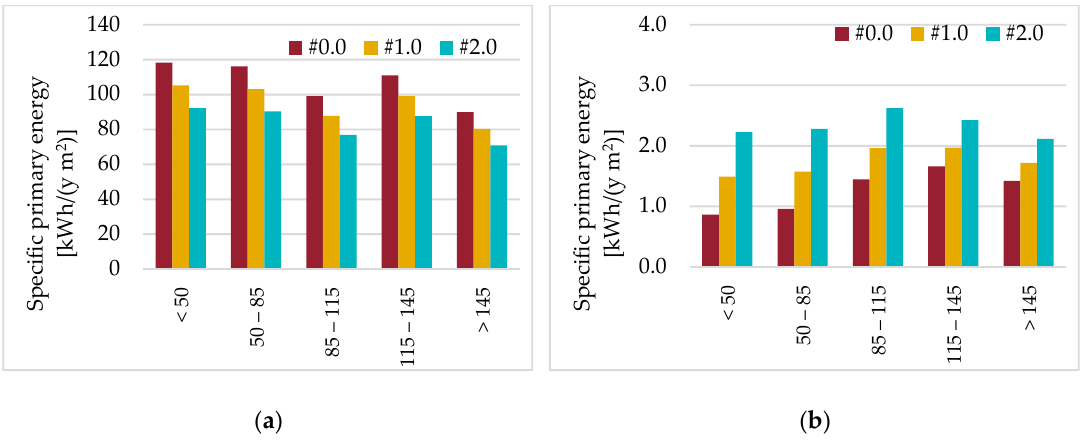
Figure 10. Milan: Specific primary energy consumption. ( a ) Heating; ( b ) cooling.